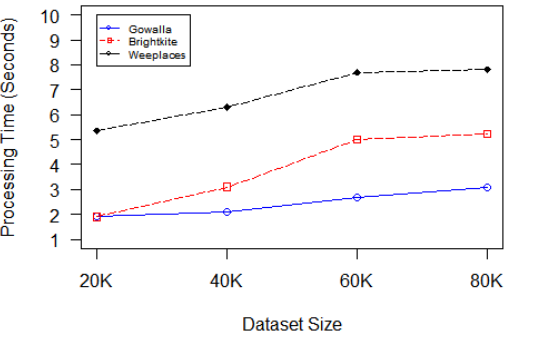
Figure 12. Effect of dataset size on processing